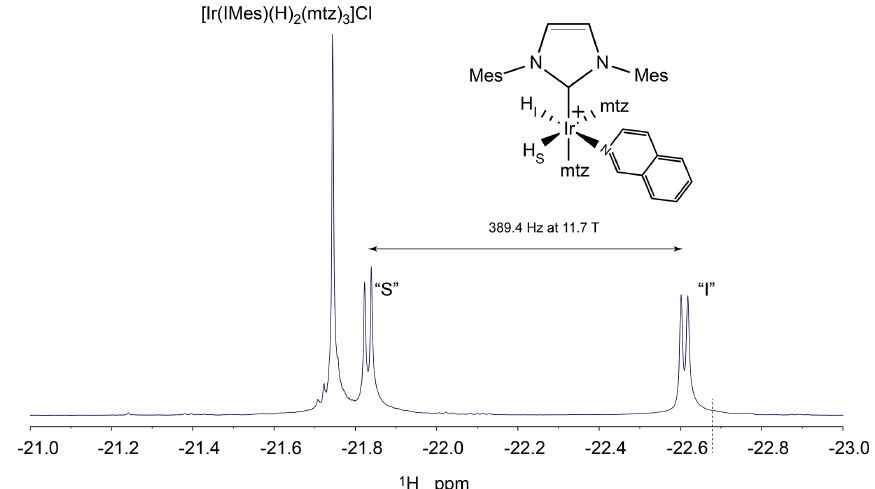
Figure B1. PHIP-NMR spectrum of the hydride region of a solution of isoquinoline 50µM, iridium–IMes complex 0.8mM, mtz 15mM in methanol-d 4 in the presence of 5bar 51% enriched p-H 2 . The experiment was recorded with 16 scans at 25 ◦ C using a SEPP pulse sequence on an Agilent Unity Inova NMR spectrometer operating at 500MHz proton resonance frequency. The structure of the asymmetric complex formed by mtz and isoquinoline is indicated together with the assignment of the two hydrides. The frequency difference between the two hydride signals at 500MHz is reported. The dotted line in proximity to the signal of hydride “I” indicates the selective excitation frequency for the hydrides employed in the kinetics experiments described in Sect.